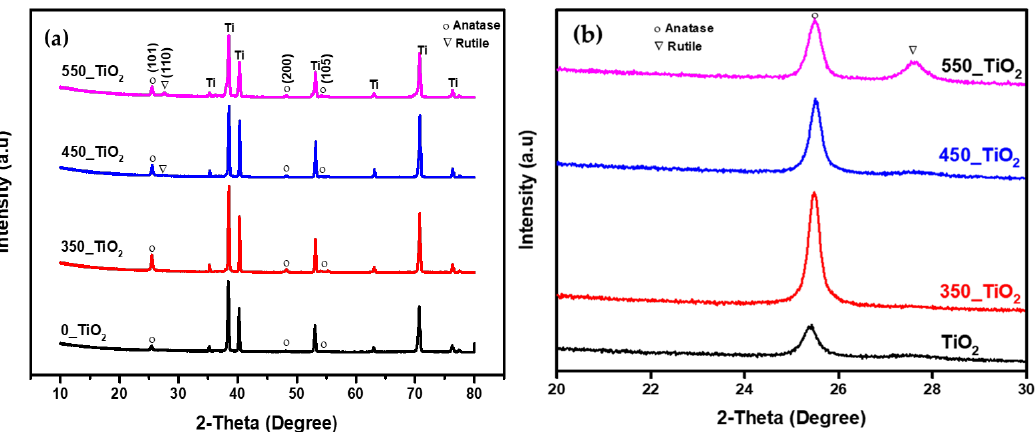
Figure 8. XRD patterns for TiO 2 calcined at di ff erent calcination temperature ( a , b ) magnified XRD patterns from 20 ◦ to 30 ◦ (2 θ ).